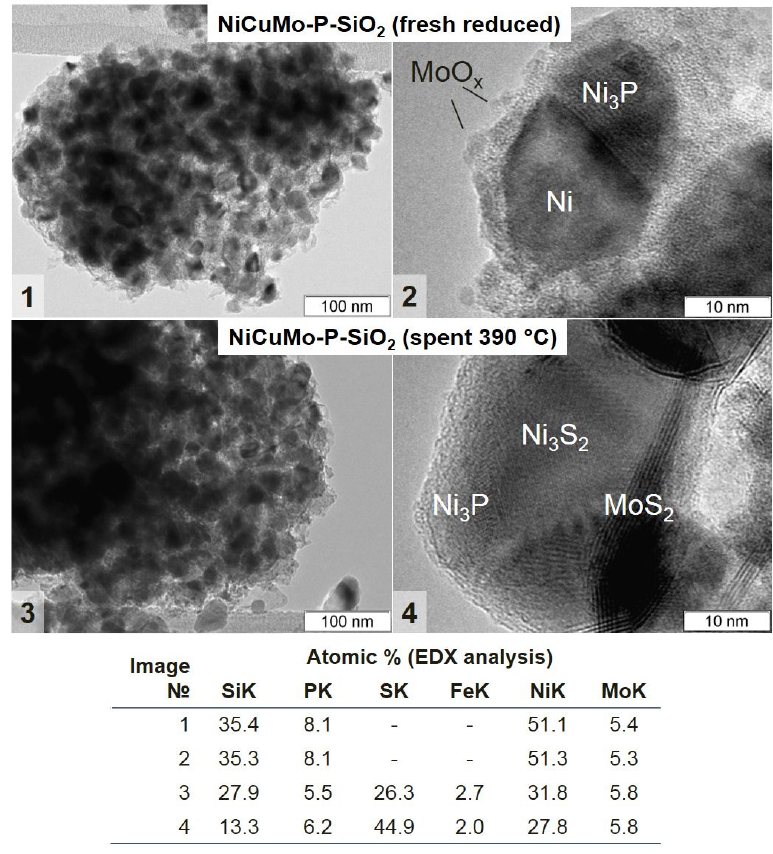
Figure 9. HRTEM images and EDX analysis data of NiCuMo-P-SiO 2 catalyst: fresh reduced ( 1 , 2 ) and spent at 390 °C ( 3 , 4 ).